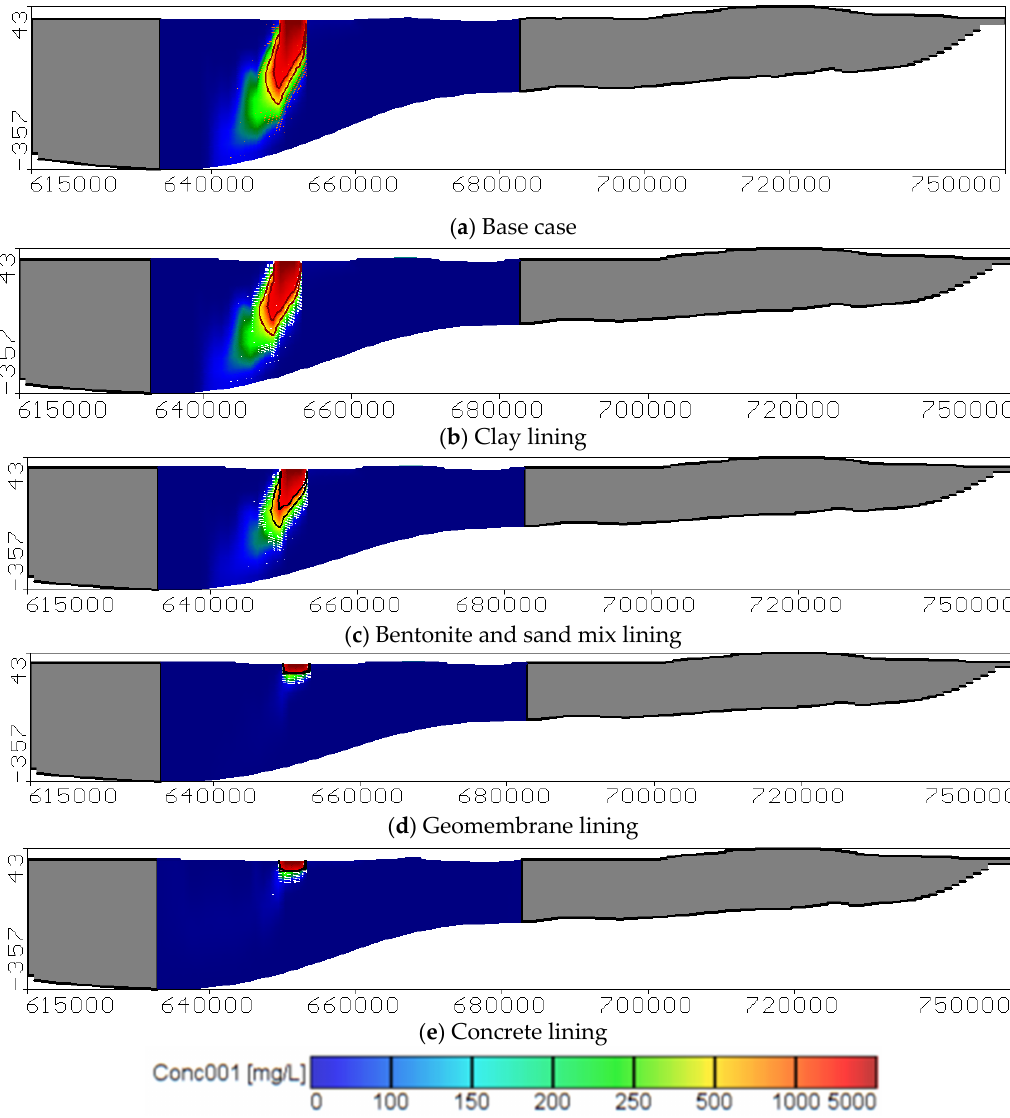
Figure 9. Vertical cross-section for TDS distribution using lining in the X direction of zone B.